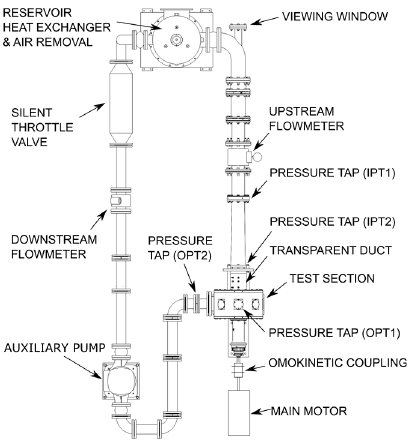
Figure 1. The cavitating pump rotordynamic test facility (CPRTF) layout in SITAEL